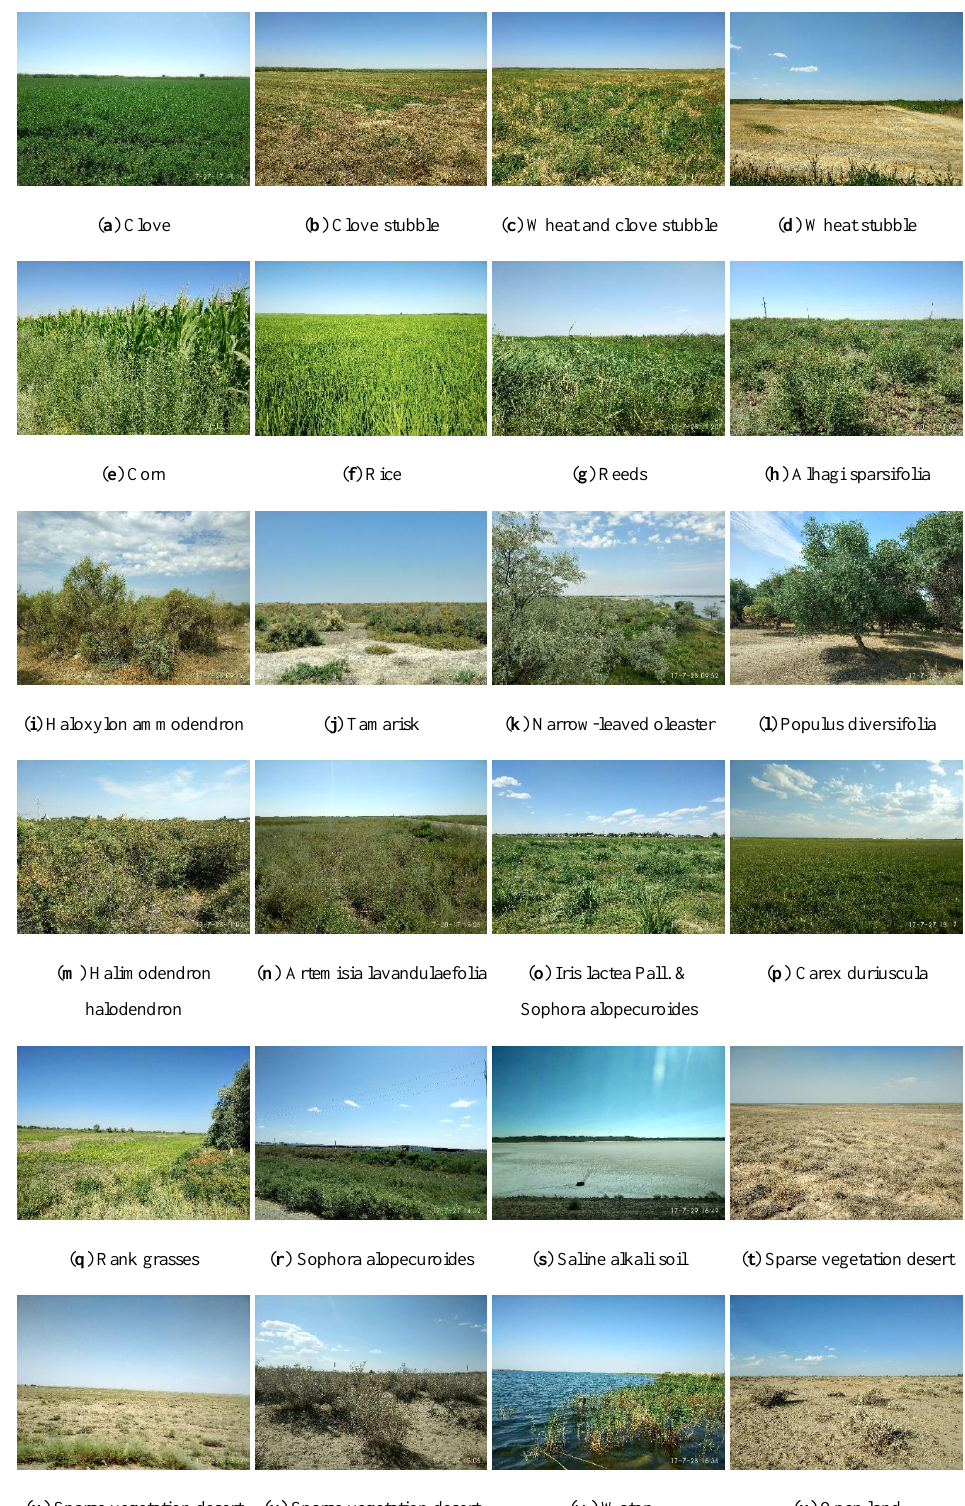
Figure 2. Ground photos of the land cover